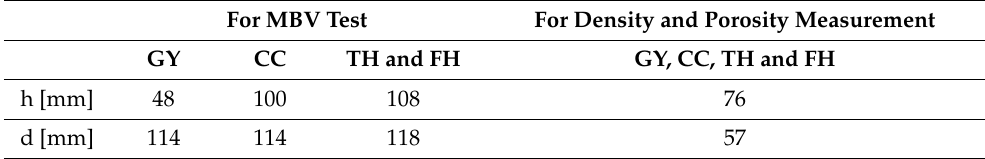
Table 3. Size of specimens for density, porosity and MBV tests.